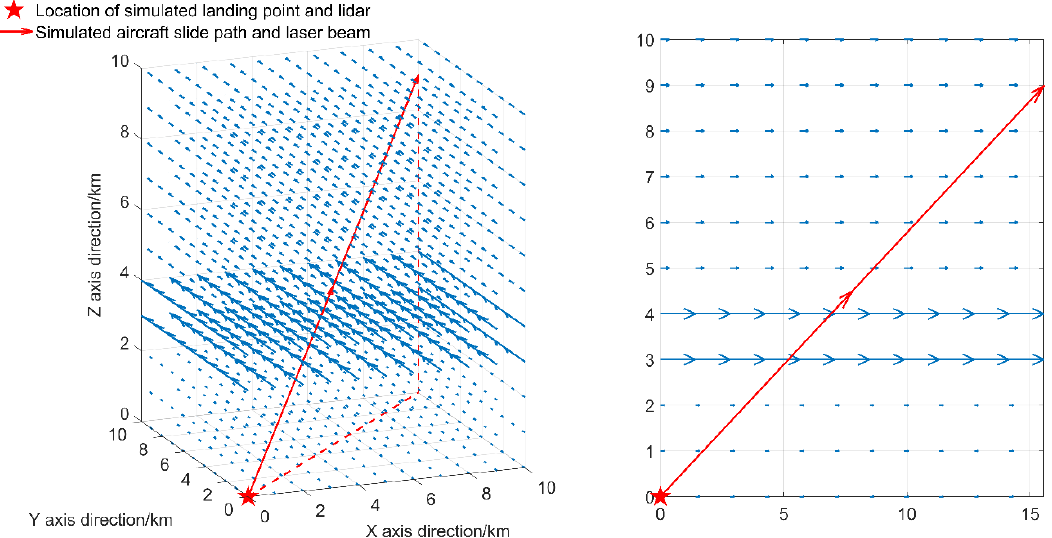
Figure 10. The left figure is the simulated low-level jet wind field in the 3-D coordinate system; the right figure is the profile view of the simulated low-level jet wind field.